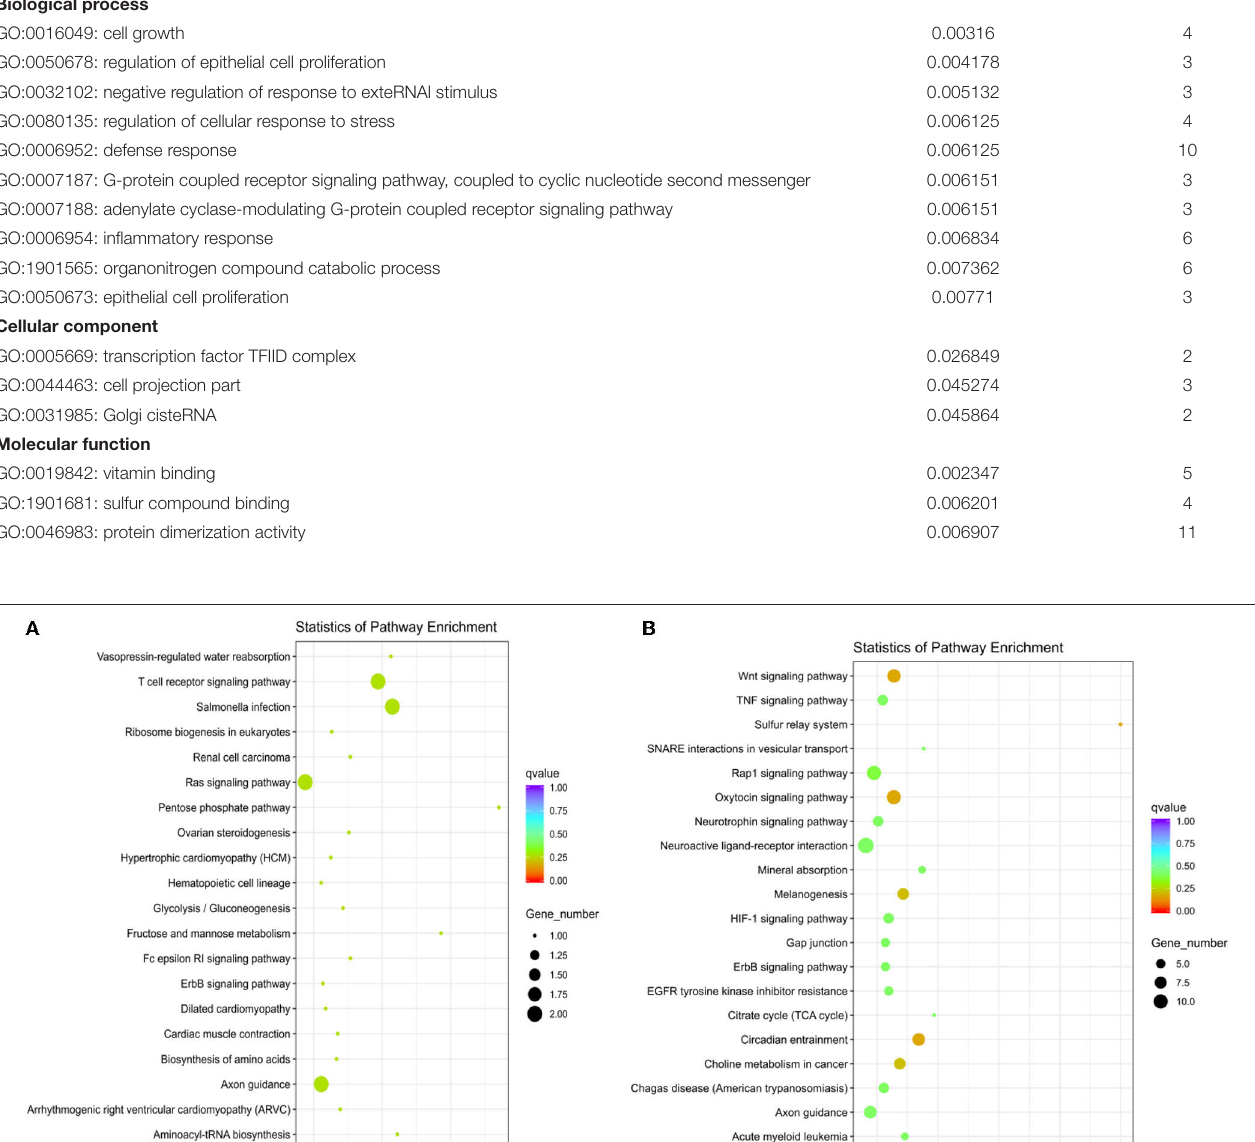
the expression levels of muscular-specific miRNA miR-1,